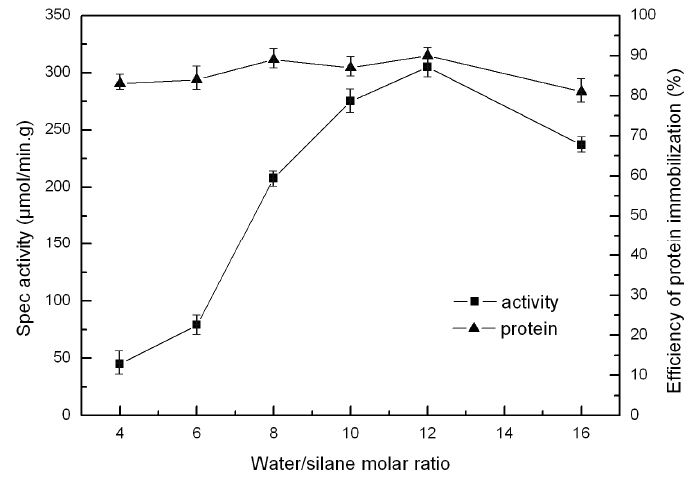
Figure 1. The effect of the water/silane molar ratio. (methyltreimethoxysilane) MTMS/TMOS (tetramethoxysilane) molar ratio of 5, 60 mg of SiO 2 , 120 mg of enzyme supply, and 120 µ L of PEG400 (polyethylene glycol).